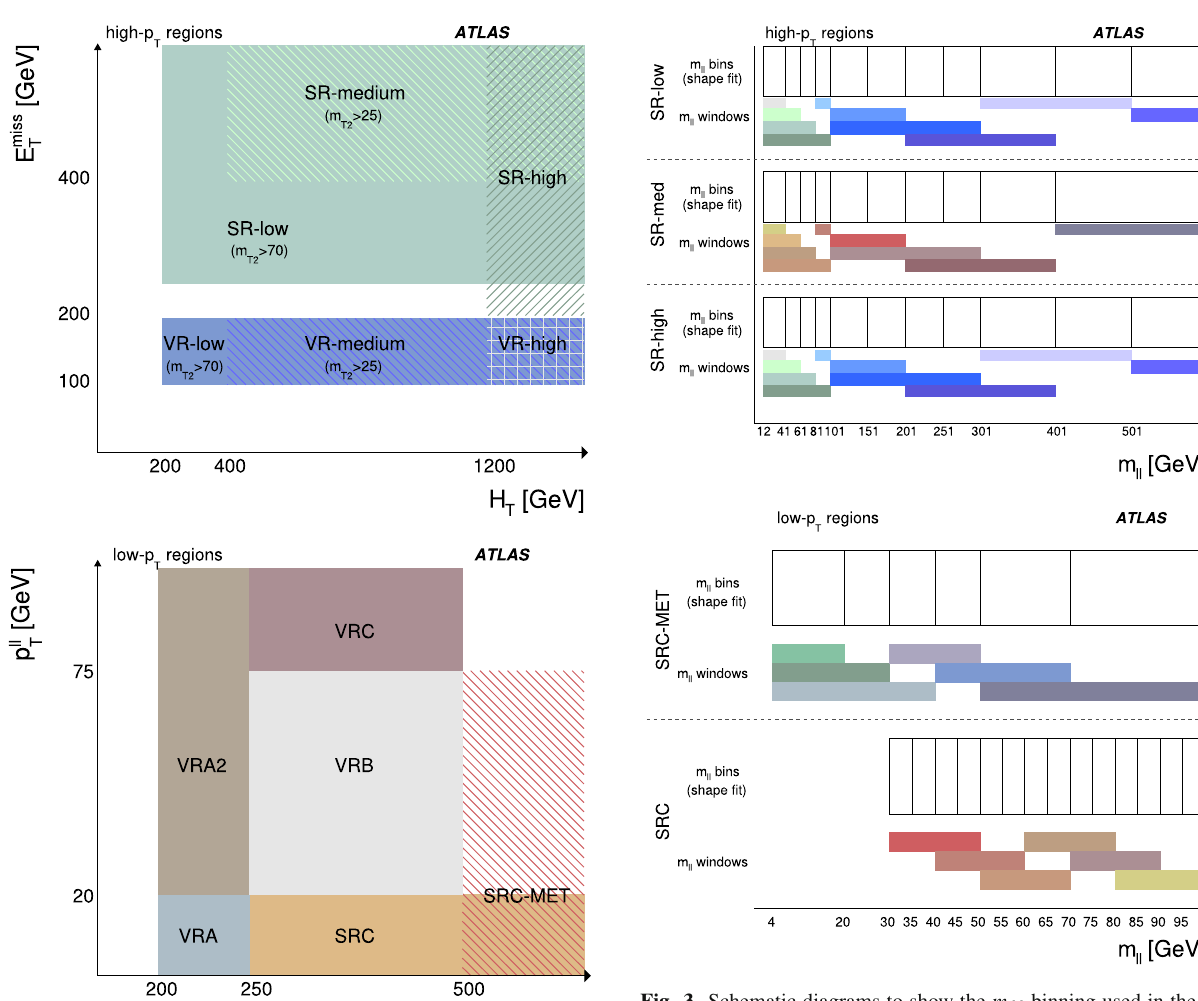
Fig. 3 Schematic diagrams to show the m (cid:4)(cid:4) binning used in the var- ious SRs alongside the overlapping m (cid:4)(cid:4) windows used for model- independent interpretations. The unfilled boxes indicate the m (cid:4)(cid:4) bin edges for the shape fits used in the model-dependent interpretations. Eachfilledregionunderneathindicatesoneofthe m (cid:4)(cid:4) windows, formed of one or more m (cid:4)(cid:4) bins, used to derive model-independent results for the given SR. In each case, the last m (cid:4)(cid:4) bin includes the overflow made. There are a total of 12 m (cid:4)(cid:4) windows for the low- p